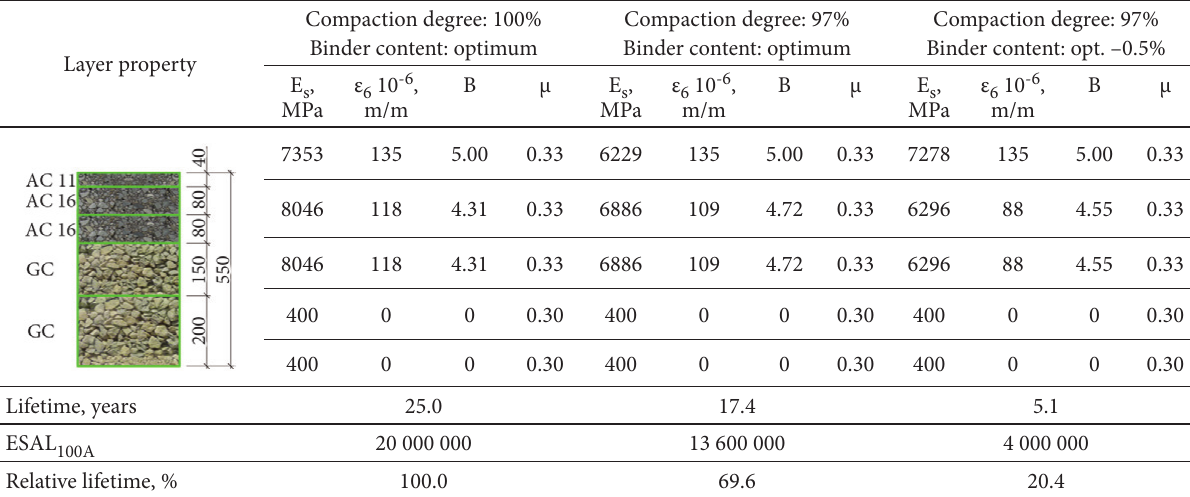
Table 8. Pavement construction and layer parameters